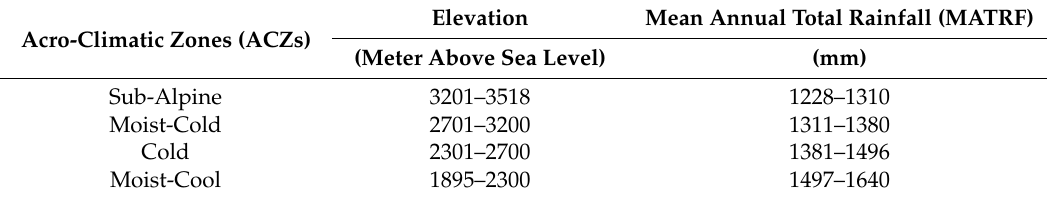
Table 4. The krigged values of the mean annual total rainfall (MATRF) in the agro-climatic zones (ACZs) of the Jema